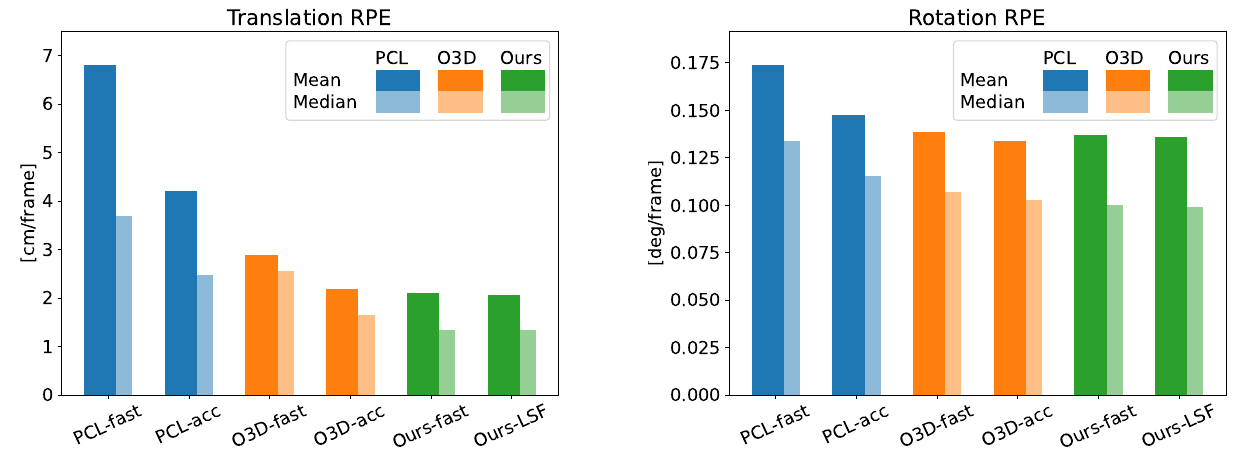
Figure 5. Comparison of the mean and median RPE of the different methods. Translational and rotational error are displayed on the left and right, respectively.